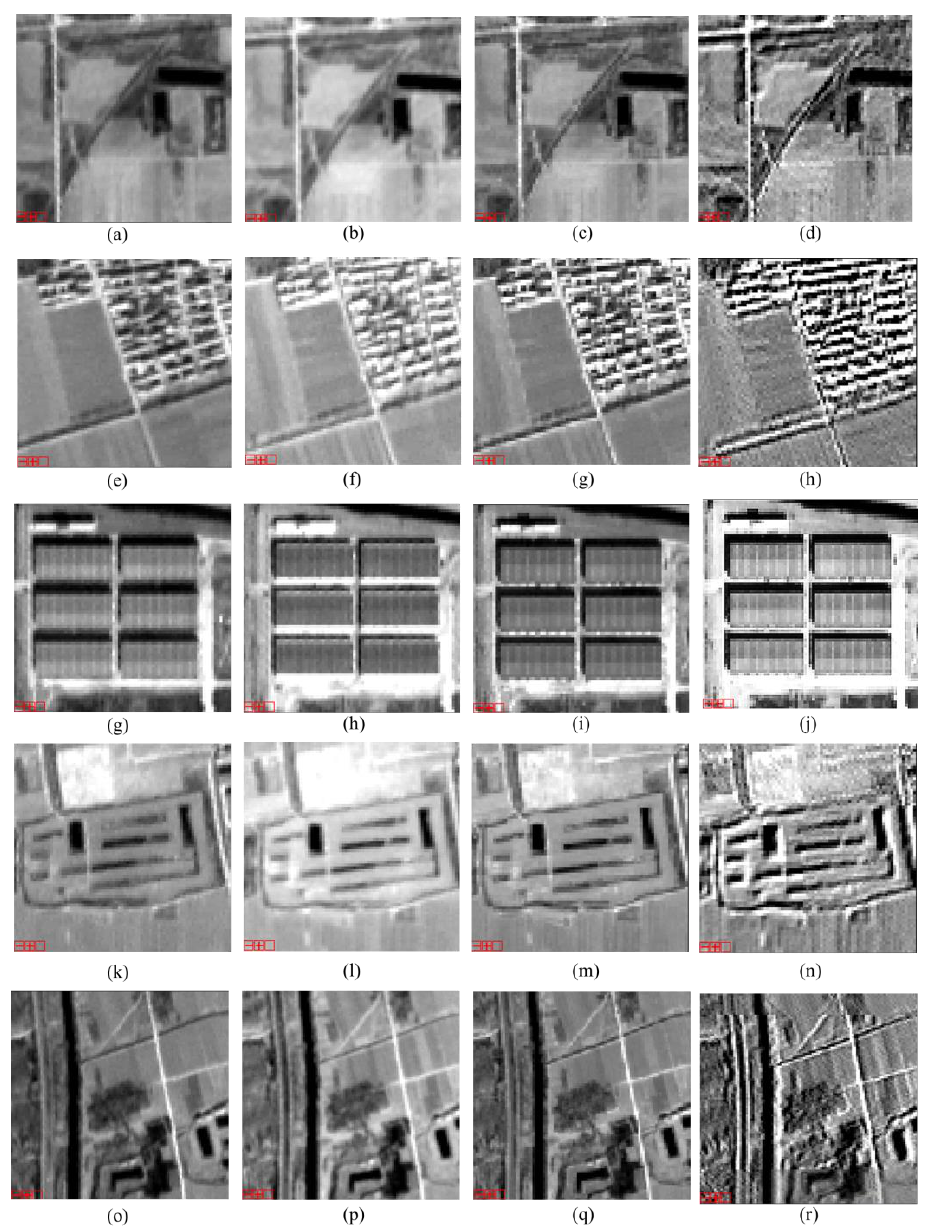
Figure 4. Detail comparisons of experimental ZY-3 images and corresponding super resolution images for different ground objects. These images are all clipped from our experimental images. From left to right of each column, the images are the forward images, the backward images, the nadir images, and their super resolution images, respectively. Different rows show different ground objects, and images from to the up down describe the paths and the canals, the paths and resident buildings, the factory buildings, the reservoirs and lands, the paths and lands, respectively . For example, from ( a – d ), we can see clearly the path and the canal in super resolution image ( d ), which are too blur to be identified in each individual ZY-3 image (the forward image ( a ), the backward image ( b ), and the nadir image ( c )).